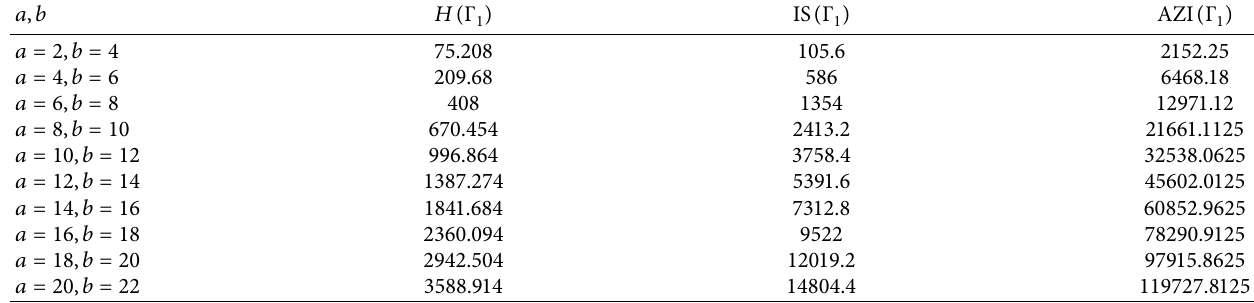
C and comparison between H ( Γ 5 7 ) of VC C 1 5 7